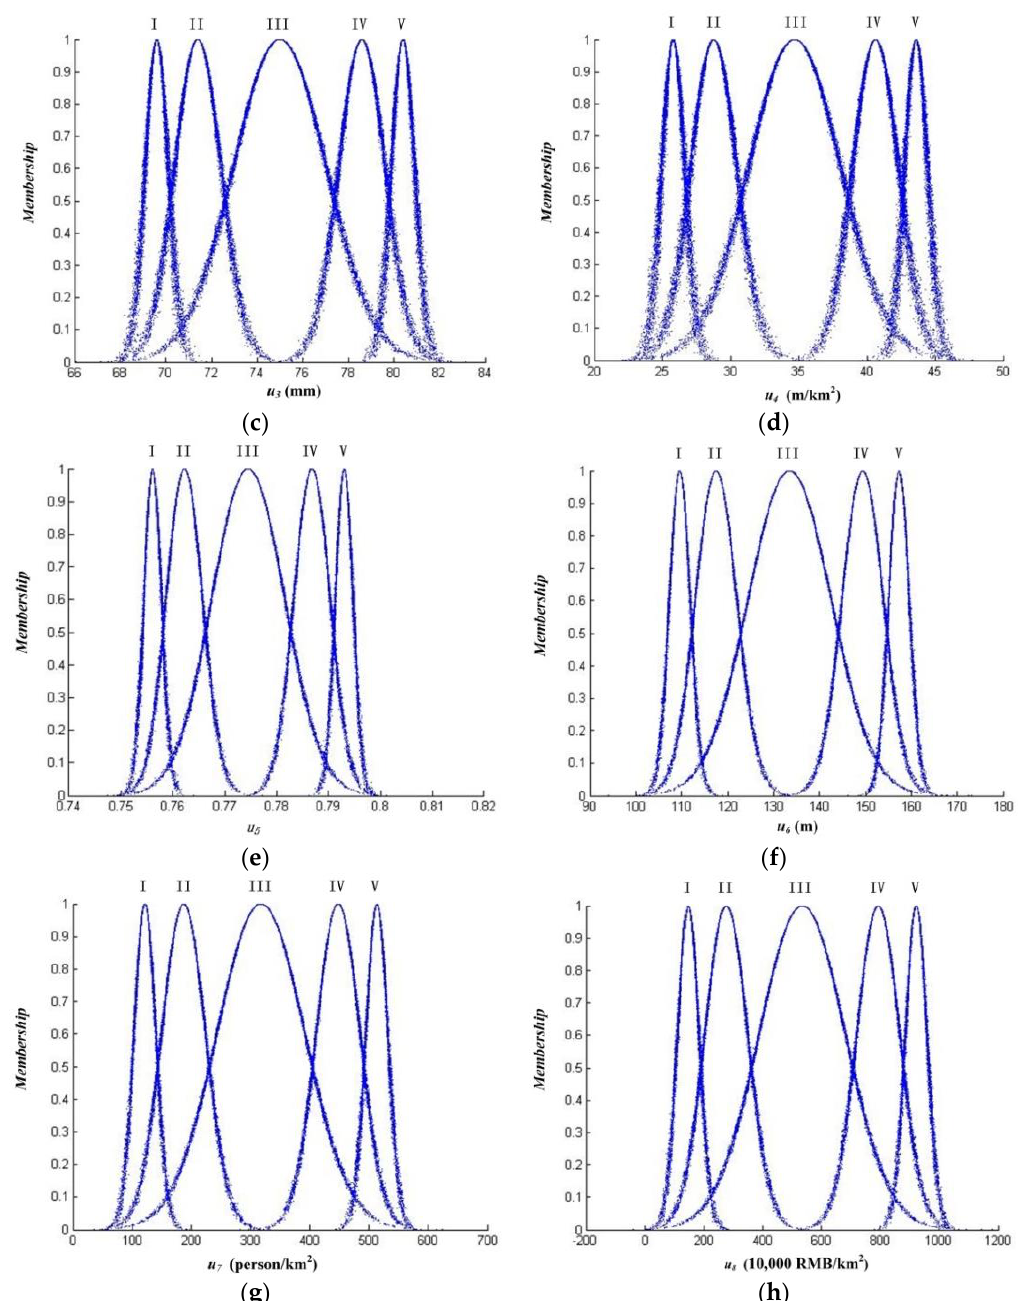
Figure 5. Cloud model expression of eight indices with five levels for risk evaluation of mountain torrent disaster. ( a ) Cloud model expression of index u 1 ; ( b ) cloud model expression of index u 2 ; ( c ) cloud model expression of index u 3 ; ( d ) cloud model expression of index u 4 ; ( e ) cloud model expression of index u 5 ; ( f ) cloud model expression of index u 6 ; ( g ) cloud model expression of index u 7 ; and ( h ) cloud model expression of index u 8